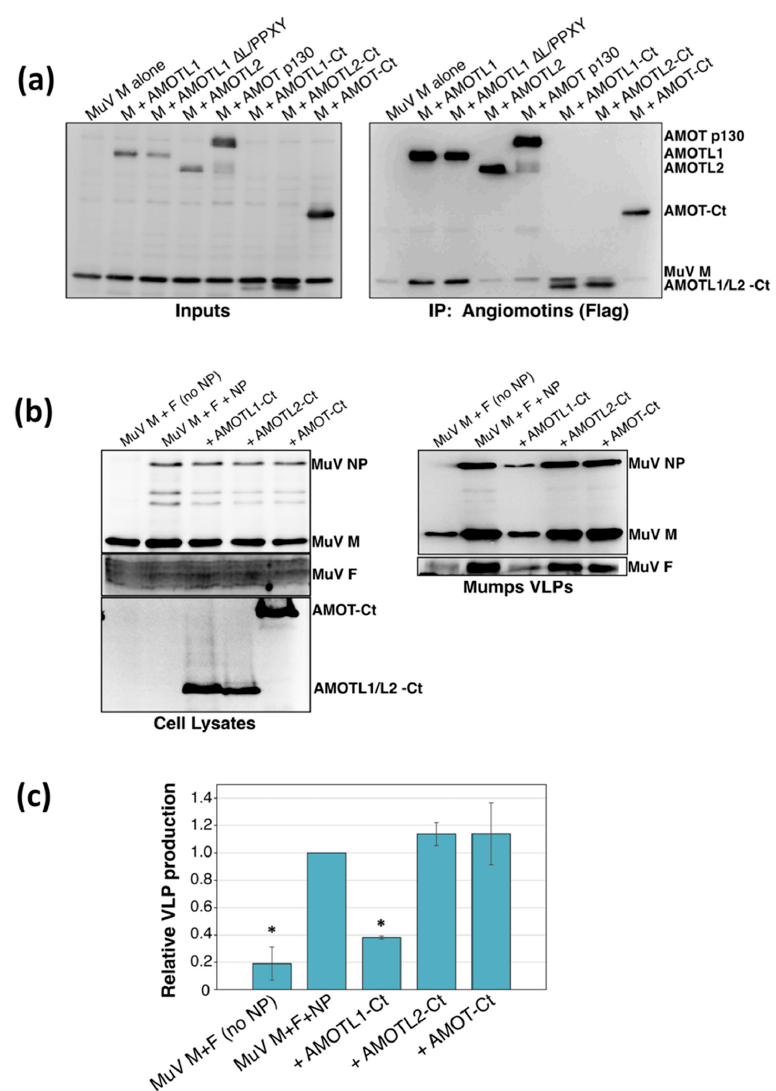
Figure 4. Mumps virus M protein binds to AMOTL1, but not to AMOT or AMOTL2. ( a ) 293T cells were transfected to produce mumps virus M protein together with the indicated Flag-tagged angiomotins. Cells were lysed in a solution containing 0.5% NP-40, and immunoprecipitation was carried out using a combination of anti-Flag and anti-mumps virus M antibodies (left), or using Flag antibody only (right). Proteins were fractionated on SDS gels and detected by immunoblotting. ( b ) 293T cells were transfected to produce mumps virus M, F, and NP proteins together with the indicated angiomotin-derived polypeptides. VLPs from culture supernatants were purified by centrifugation through sucrose cushions followed by flotation on sucrose gradients. Cell lysates and purified VLPs were fractionated on SDS gels and proteins were detected by immunoblotting. ( c ) Three independent experiments were performed as described for panel ( b ), and VLP production efficiencies were calculated as described in the legend to Figure 3. Error bars indicate standard deviations. Differences from the values obtained in the absence of polypeptide co-expression were assessed for statistical significance by using a two-tailed Student’s t -test, and p values less than 0.01 are denoted by an